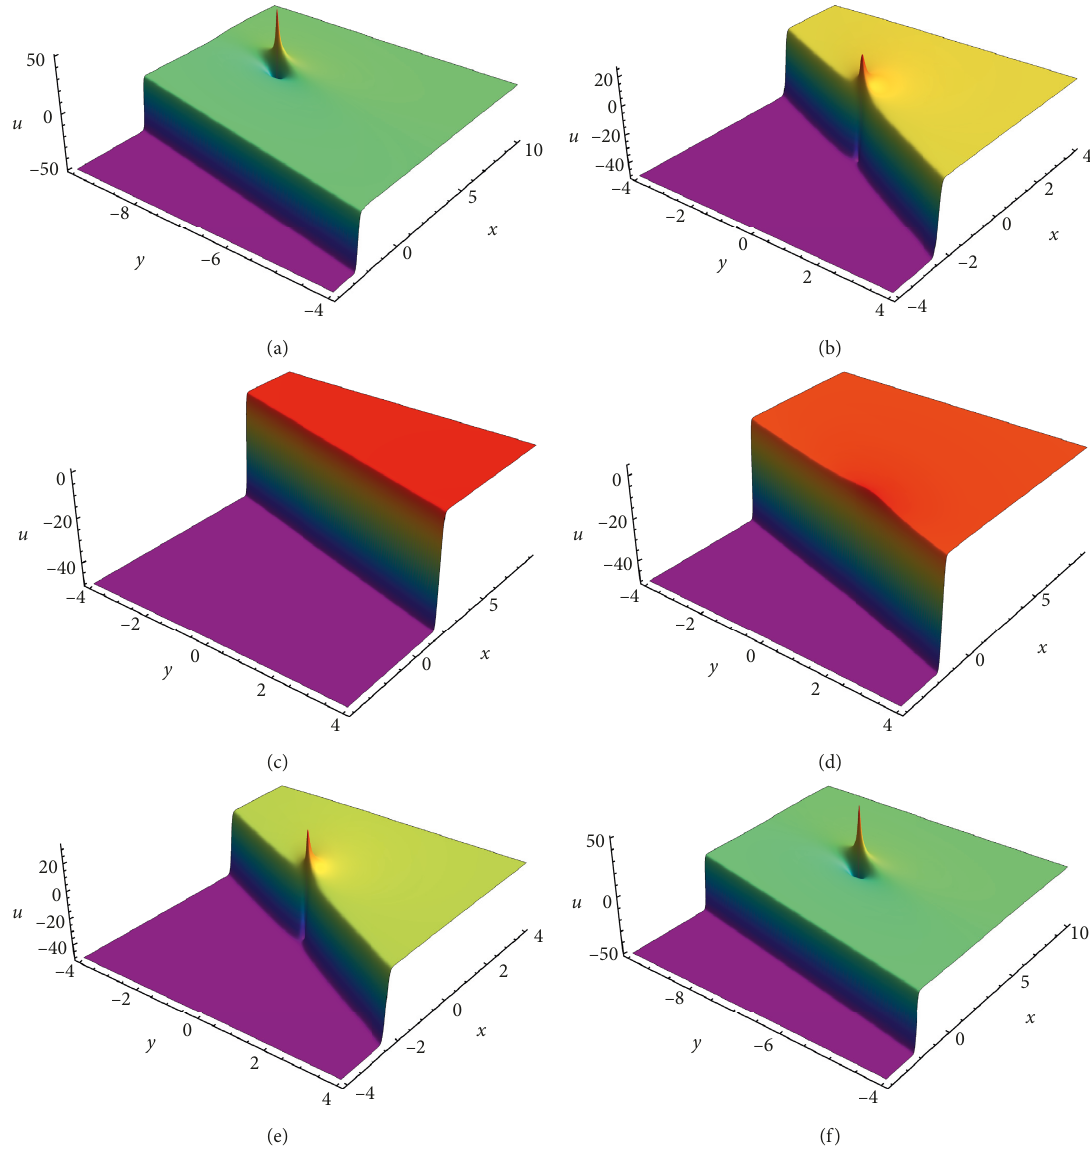
Figure 5: The three-dimensional plot of periodic interaction between single-lump wave and one-kink soliton via the solution (18). The relevant parameters are a (b) t � 0; (c) t � 1; (d) t � 3; (e) t � 3 . 15; (f) t �